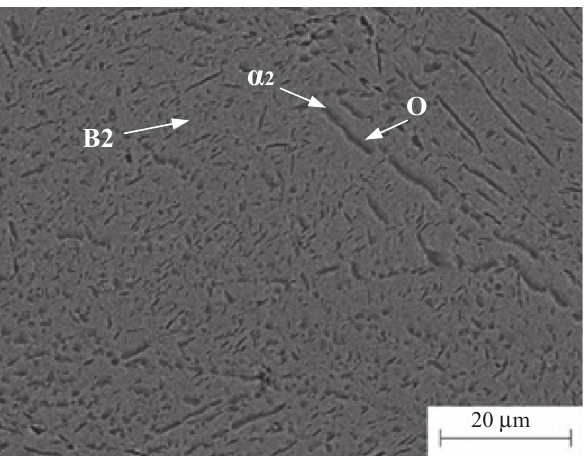
Figure 1: Microstructure of Ti22Al25Nb before the hot compression